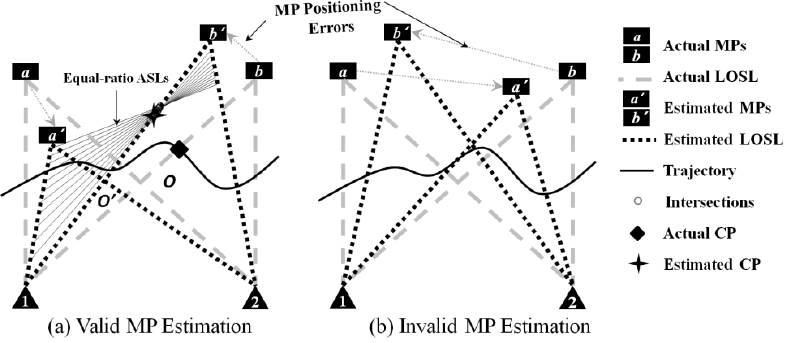
Figure 7. The crossing point (CP) estimation based on the equal-ratio transverse (ERT) method under noisy MP estimation.